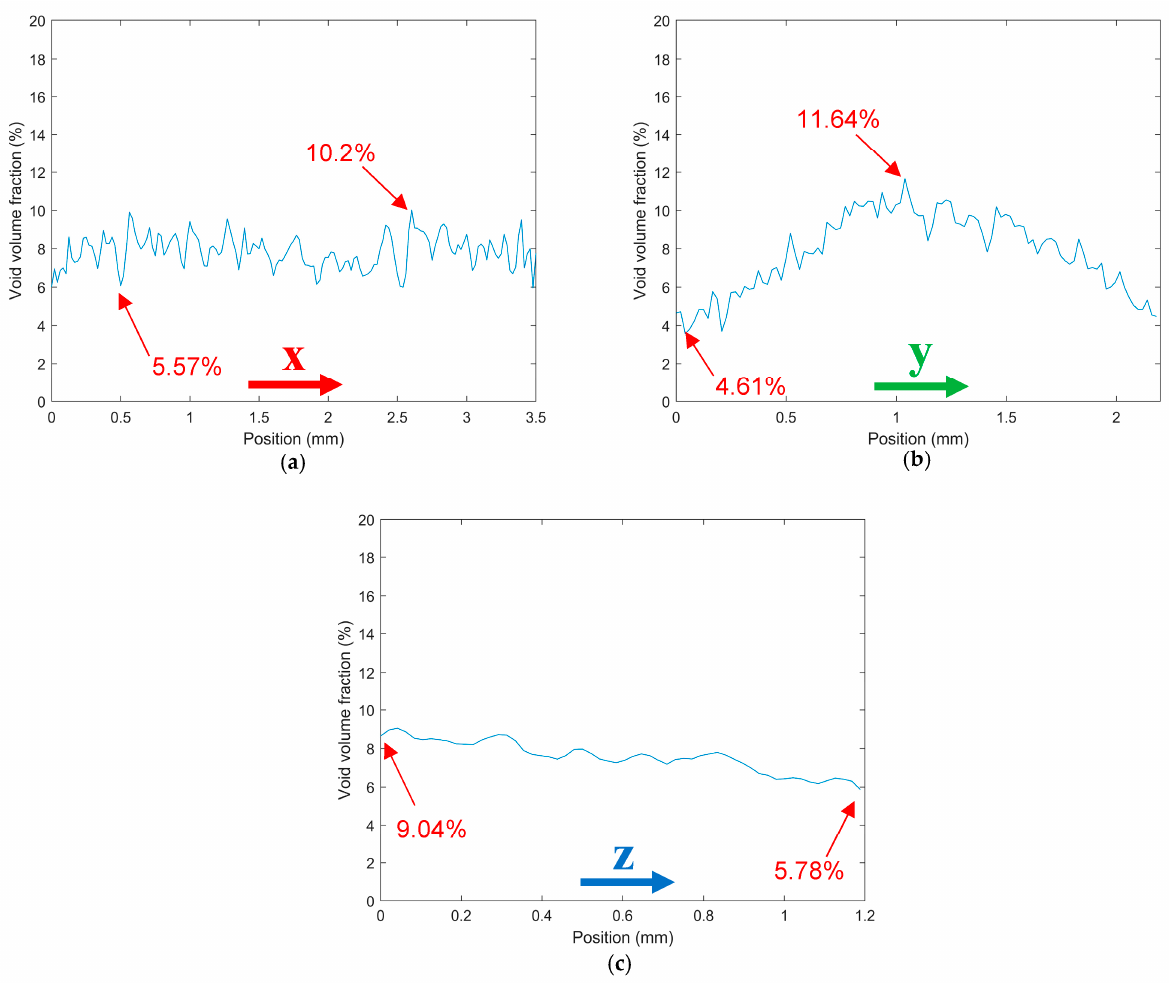
Figure 3. Void volume fraction within the different directions of a SCF/ABS pellet: ( a ) along the X-direction; ( b ) along the Y-direction; ( c ) along the Z-direction.